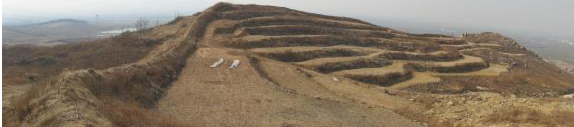
Figure 12. Panoramagram of city Zhu and Yi Mountain